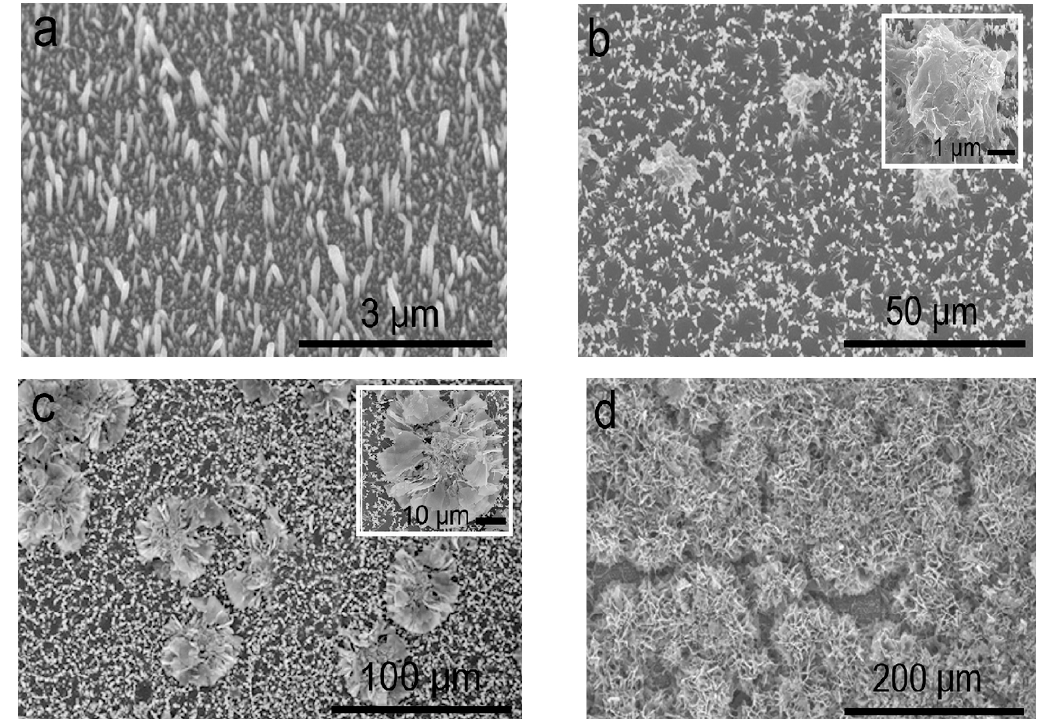
Figure 17. The e ff ect of growth time on morphological evolution of flower-like ZnO nanostructures in preheated aqueous Zn(NO 3 ) 2 · 6H 2 O and HMTA solutions: ( a ) 2 h, ( b ) 4 h, ( c ) 6 h, and ( d ) 24 h. Reproduced from [231] under the Creative Commons Attribution License.